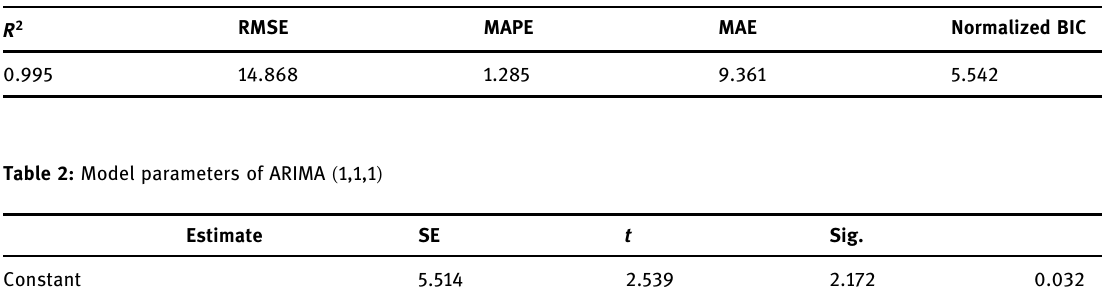
Table 1: Model fi t statistics of ARIMA ( 1,1,1 )